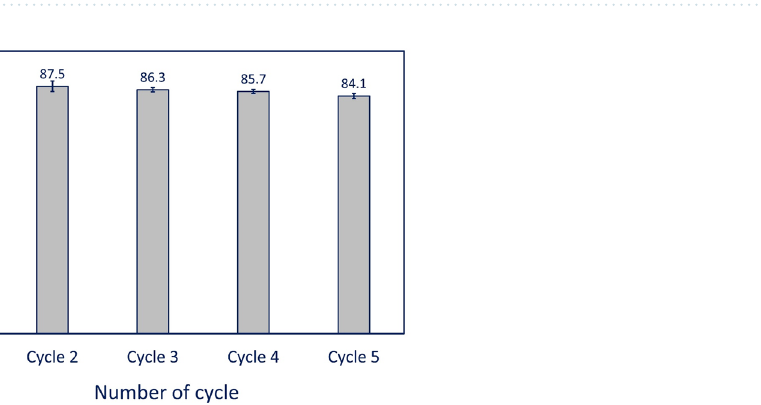
Figure 9. The prospective photocatalytic mechanism for the degradation of methylene blue using green synthesized Se-NPs.